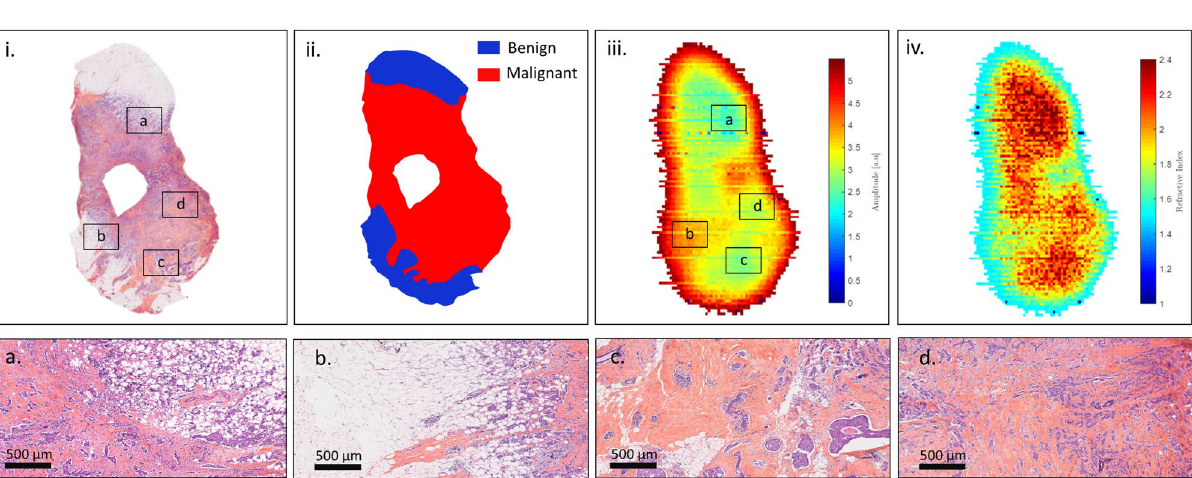
Figure 9. TS#1 tissue sample classification maps at 550-GHz for (cid:31) best thresholds. “Not applicable” refers to regions where the binary pathology classification and the binary terahertz classification image do not match spatially. The values listed in each box are respectively standing for the refractive index threshold, the true positive rate and the false positive rate.